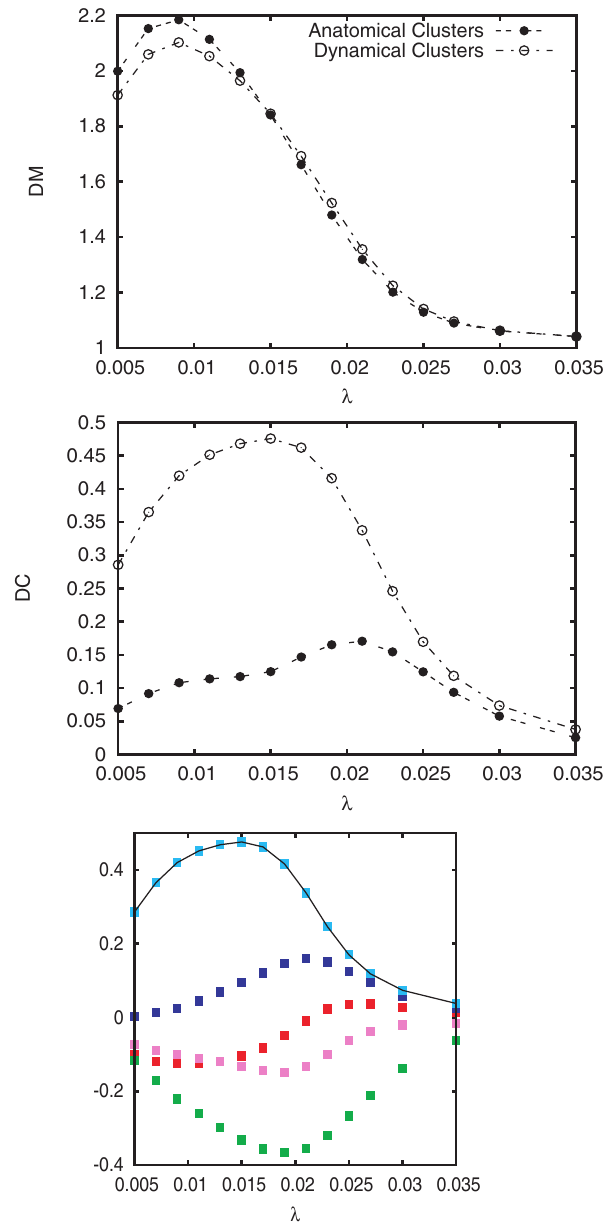
Figure 7. Transition from Modular to Centralized organization of synchronization. The two upper plots show the evolution of the dynamical modularity DM and the dynamical centralization DC as a function of l . Both panels show the evolution of the above properties for the network described by means of both the original 4 modal clusters and the 5 new modules including the Rich-Club. The panel in the bottom shows the evolution of the DC of the 5 new modules obtained by replacing in Equation (4) the term max a f r a g by each r a corresponding to the new 5 modules. From the curves it is clear that the dynamics is centralized around the Rich-Club.